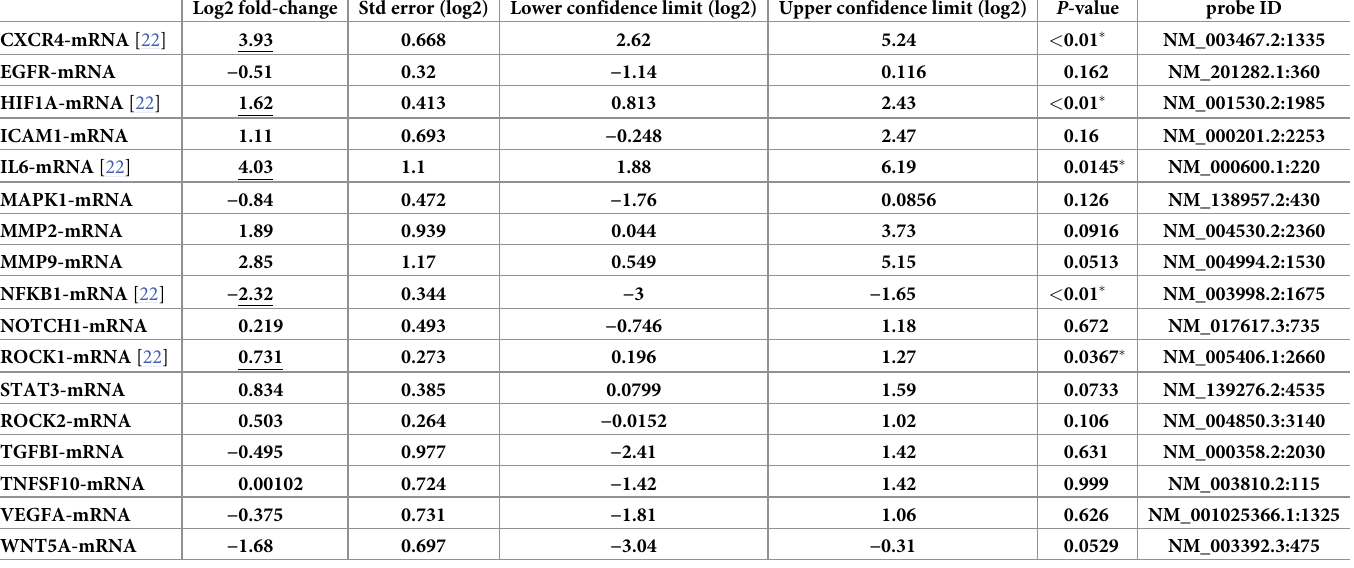
Tis and Tadv groups according to AJCC T grading (n = 4 in each group) (Table 3). Expression of mRNA for CXCR4 , HIF-1 α , IL-6 , NFKB1 , and ROCK1 differed significantly ( P < 0.05) between the Tis and Tadv groups. We have already published some of these results [24]. the multiple correction test was also performed by the Benjamini-Yekutieli method, however in that case were no significant difference (P < 0.05). Table 3. Gene expression–associated cancer progression between Tis and